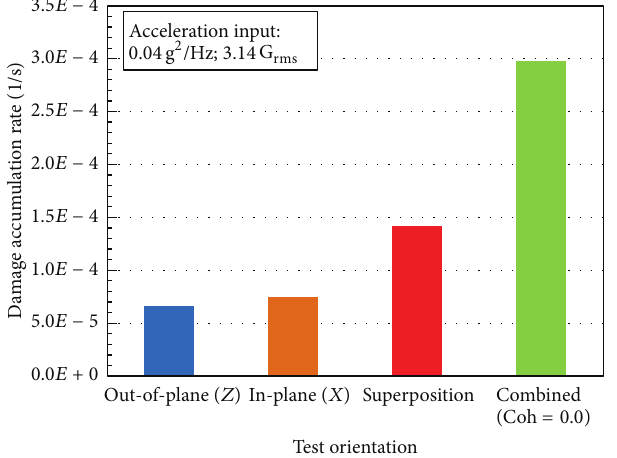
Figure 13: Component 2 damage accumulation rate at 3.14G rms .